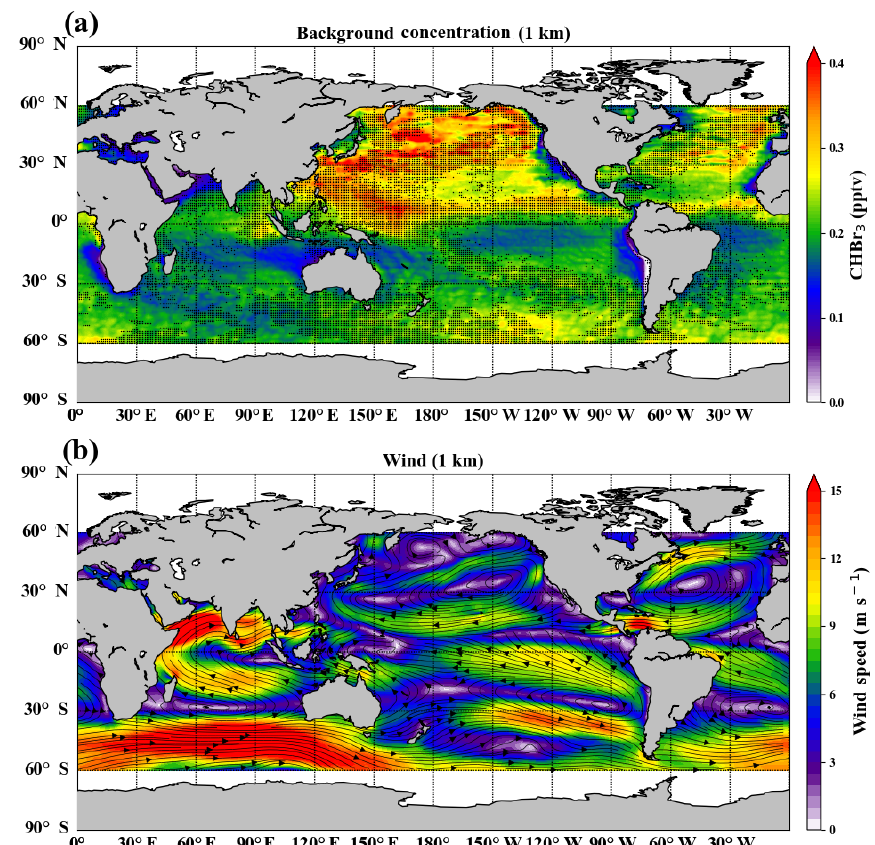
Figure 7. Same as Fig. 6, but for the OASIS